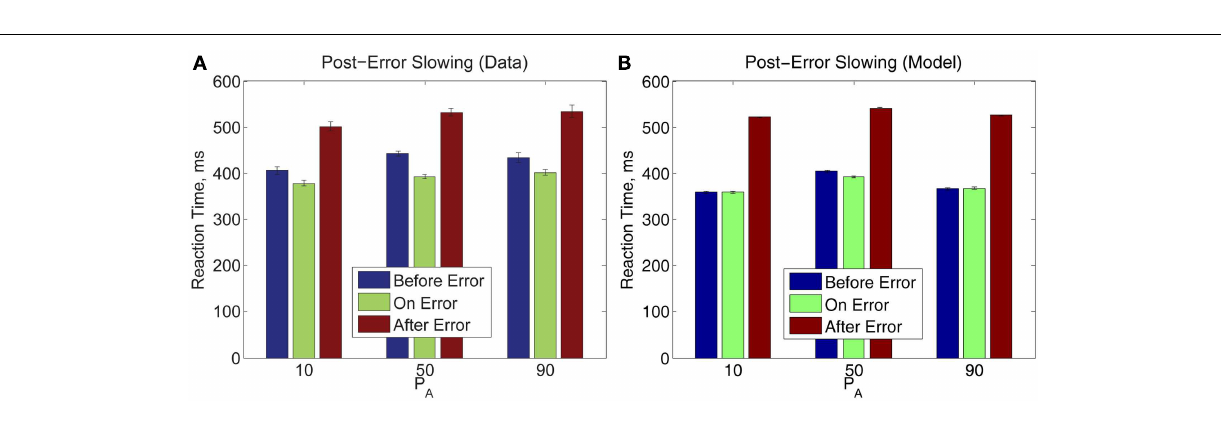
FIGURE 9 | (A) Post-error slowing in Experiment 2 data is independent of P A . (B) The model fit also predicts post-error slowing but does not fully account for pre-error speeding.The error bars in